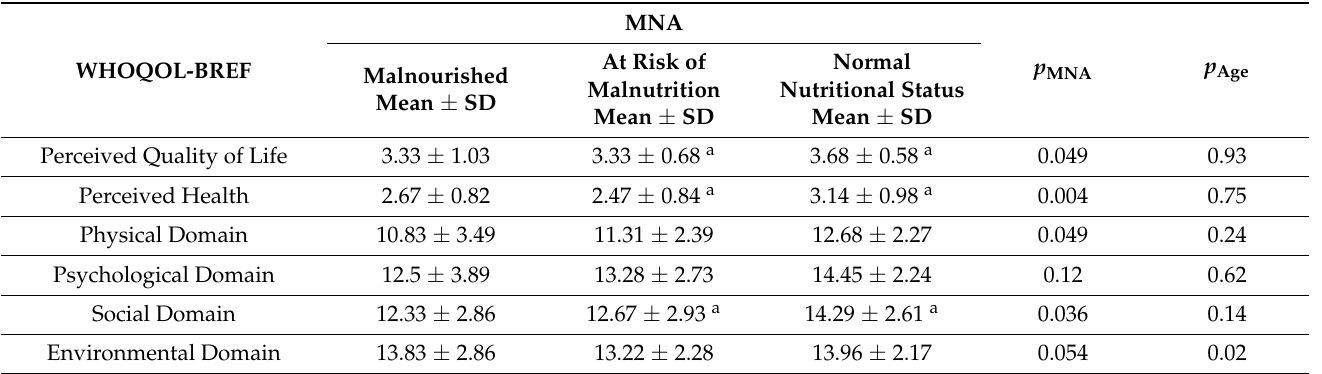
Table 5. Comparison of QoL in specific WHOQoL-BREF domains by nutritional